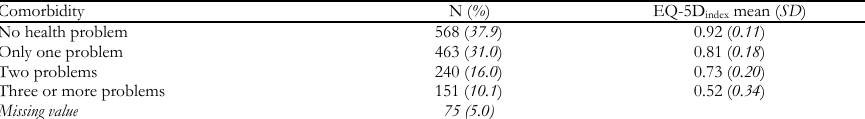
Comorbidity and EQ-5D index mean and standard deviation